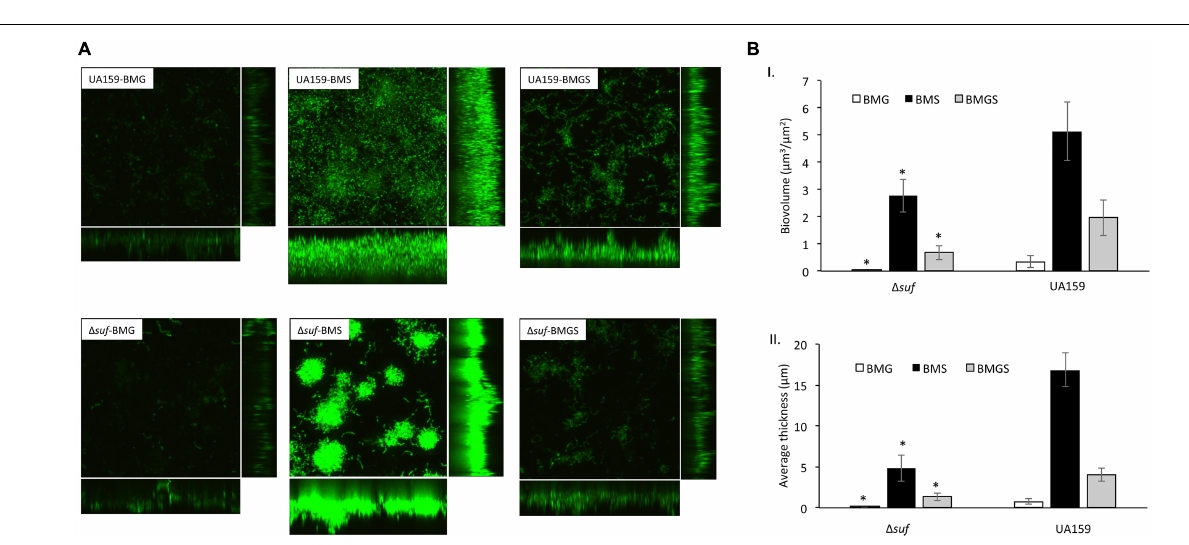
FIGURE 6 | Confocal microscopic and COMSTAT analysis of biofilms. Streptococcus mutans wild-type UA159 and (cid:49) suf::kan r mutant ( (cid:49) suf ) were grown on hydroxylapatite disks in BM medium with glucose (BMG), sucrose (BMS), and glucose plus sucrose (BMGS), and the 24 h biofilms were analyzed using confocal microscopy. Following image acquisition, quantitation of the biofilm biovolume and average thickness were further analyzed using COMSTAT. Panel A shows representative restructured three-dimensional images of the biofilms of the wild-type and mutant (cid:49) suf::kan r . Panel B shows results of the COMSTAT analysis of biovolume (I) and thickness (II). The data presented here are means ( ± standard deviation) of more than three independent experiments, with * indicating significant differences at P <